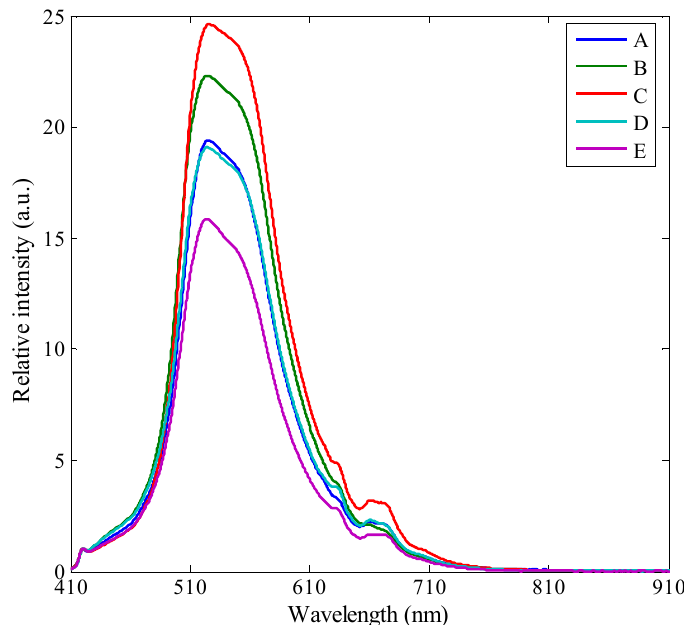
Figure 1. Average fluorescence spectra of five brands of yogurt (HuaHuaNiu, JunLeBao, MengNiu, YiLi, and GuangMing).